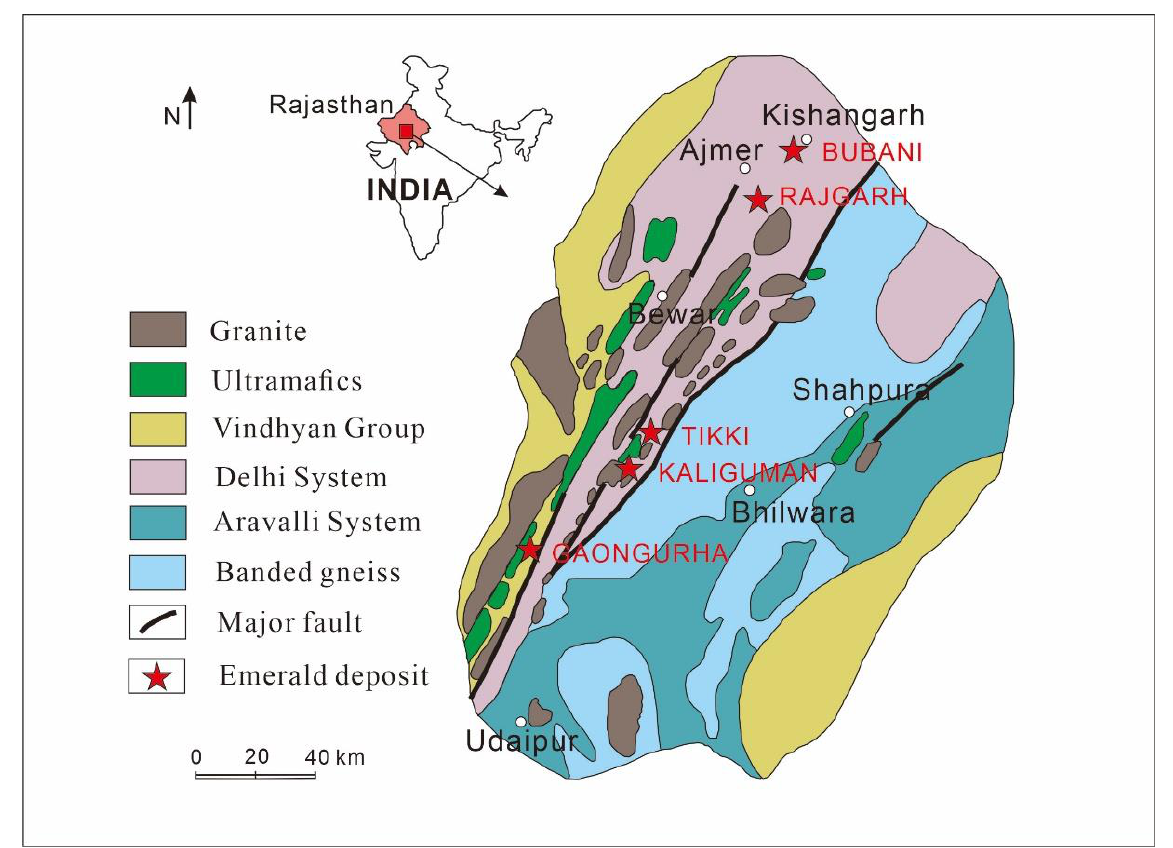
Figure 1. Simplified geological map of the Rajasthan Emerald Belt, NW India, situated approximately at the contact between the Delhi System, to the NW (calc-silicate rocks, limestones, sandstones, schists, and gneisses), and the Aravalli System, to the SE (mostly schists and gneisses). Modified from [15,20,32].